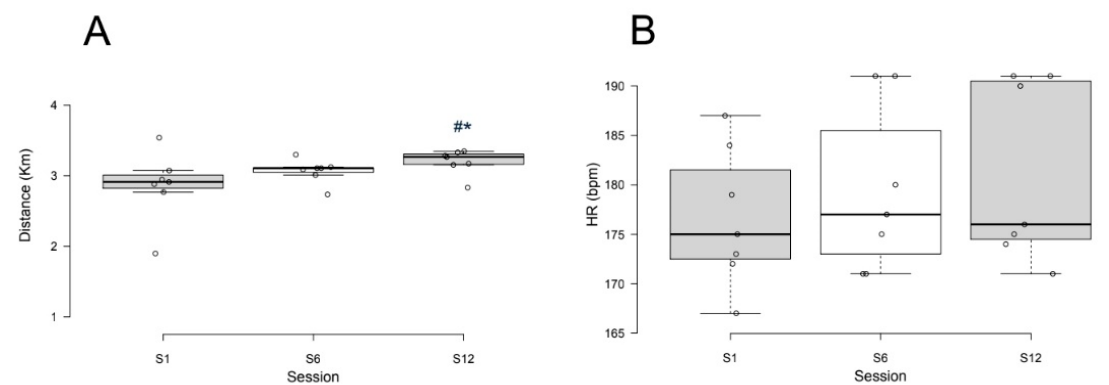
Figure 2. Distance run during the first session of training (S1), at the middle of the protocol (S6), and during the last session of RIT (S12) ( A ). Heart rate recorded during the RIT sessions ( B ). * p = 0.005 S1 vs. S12; # p = 0.004 S6 vs. S12. There was no interaction between CON and RIT and measurement times for VO 2max , exhaustion time, DBP, body weight, BMI, body fat %, muscle mass, and lean leg mass. Although not statistically significant, the RIT intervention showed a strong trend to reduce SBP compared to the post-test of the CON group ( p = 0.07, d = − 1.98, 95%CI = − 2.11, − 1.85) (Table 1). There was an interaction between CON and RIT and measurement times on HRrest ( p ≤ 0.001, d = 2.21, 95%CI = 2.07, 2.35). Follow-up analysis showed that HRrest increased in the CON group ( p = 0.031, 95%CI = 0.7, 13.1) and decreased in the RIT group ( p = 0.001, 95%CI = 5.6, 17.4) after the program. Mean HRrest following the program was smaller in the RIT group compared to CON ( p = 0.006, 95%CI = 4.3, 21.2) (Table 1). A correlation was found between ∆ HRrest and ∆ SBP ( r = 0.52, p = 0.02; d = 0.27, 95%CI = 0.09, 0.79) (Figure 3). There was an interaction between CON and RIT and measurement times on DP ( p ≤ 0.001, d = 2.06, 95%CI = − 19.90, 24.02). Follow-up analysis showed that DP increased in the CON group ( p = 0.012, 95%CI = 3.2, 22.7) and decreased in the RIT group ( p = 0.005, 95%CI = 4.8, 23.4) after the program. Mean DP was lower in the RIT group compared to CON following the program ( p ≤ 0.001, 95%CI = 12.1, 34.3) (Table